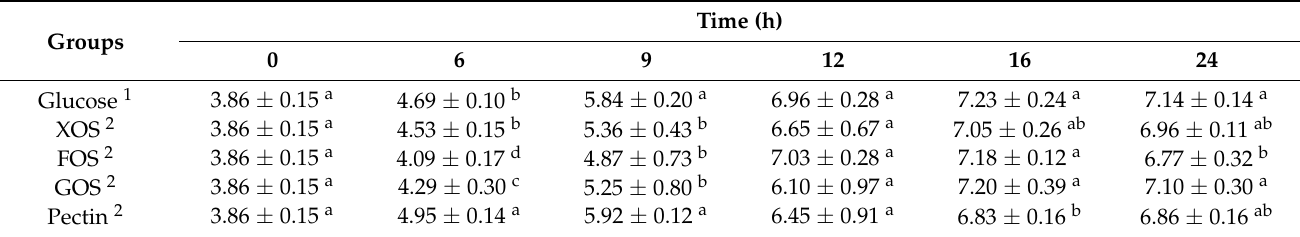
Table 1. Effects of various carbon sources at the level of 0.5% ( w / v ) on the growth of B. coagulans (Log cfu/g) in